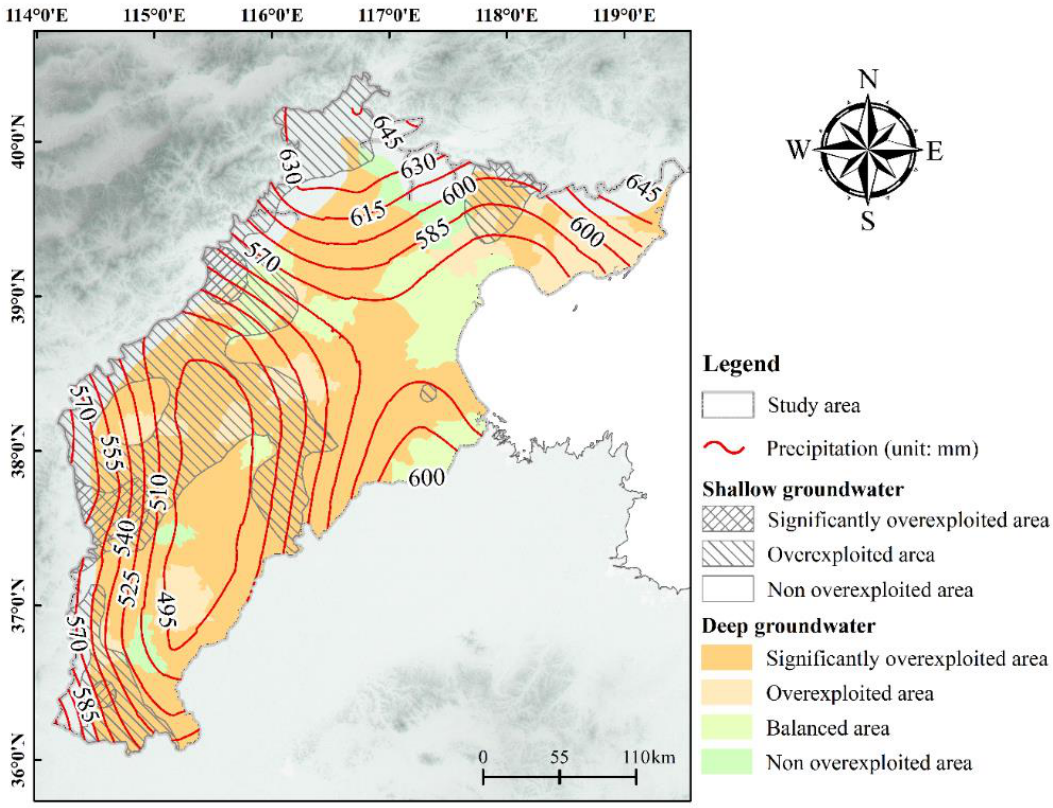
Figure 12. Precipitation and groundwater exploitation information in the study area (the groundwater exploitation information is derived from [41,56]).